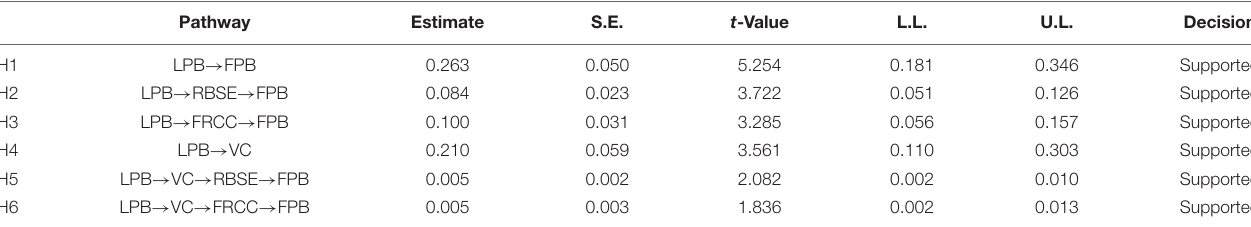
FIGURE 2 | Structural relationships. ∗∗∗ < 0.001. TABLE 5 | Summary of hypothesis testing.